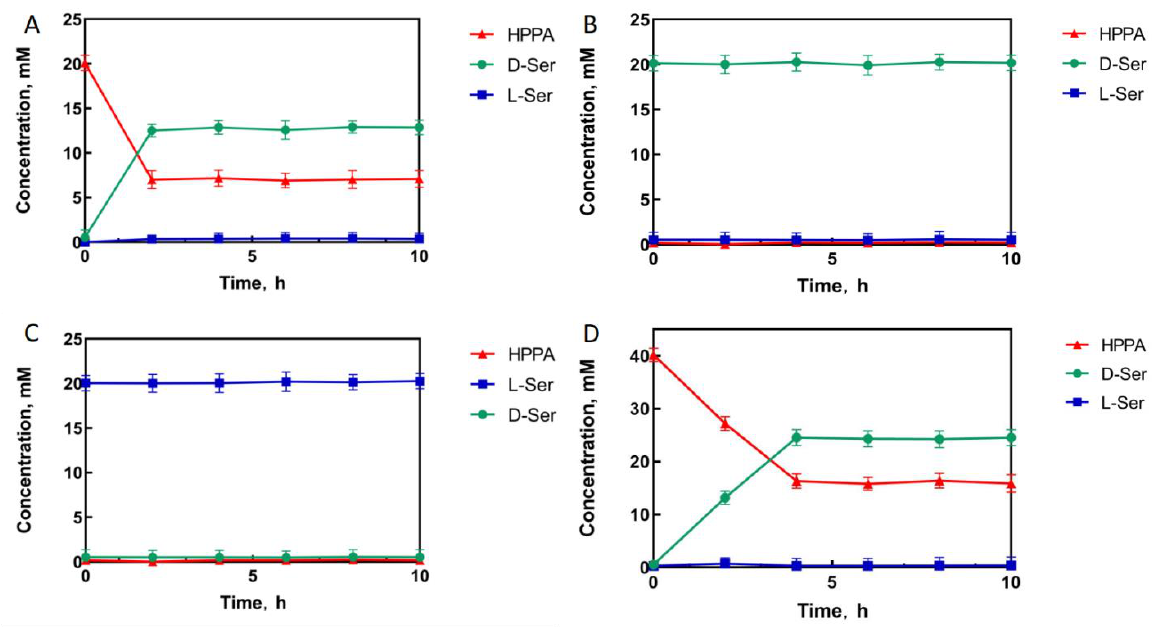
Figure 5. The mutant D92E/D122W/M152S (M3) catalytic process with HPPA (( A ): 20 mM; ( D ): 40 mM), D-serine ( B ), and L-serine ( C ) as substrates, respectively.